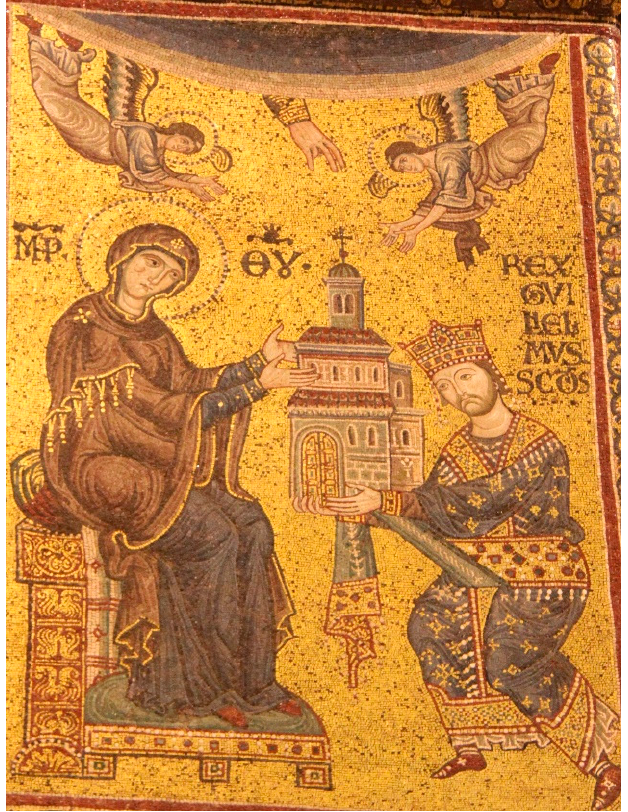
Figure 4. William II of Hauteville offering the Cathedral of Monreale to the Virgin , mosaic, 1177–1183. Monreale, Cathedral, Presbytery, Choir. Photo taken by author.